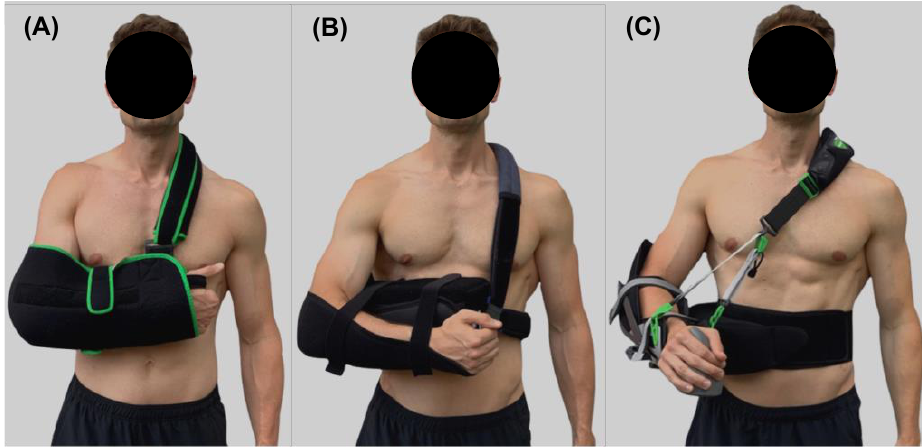
Figure 1. Applied shoulder orthoses. Note: ( A ) Orthosis #1 (shoulder sling); ( B ) Orthosis #2 (abduc- tion pillow); ( C ) Orthosis #3 (variably adjustable orthosis).